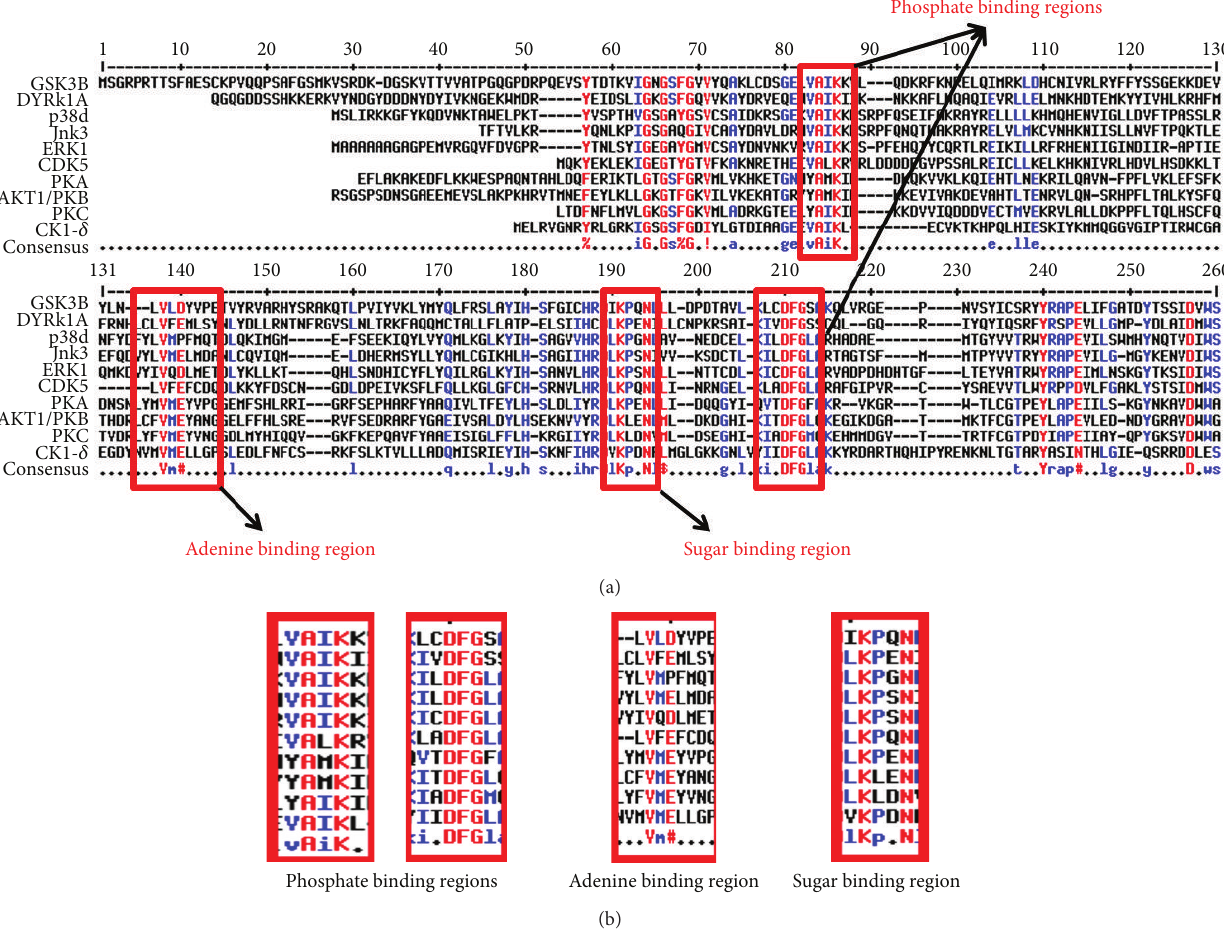
Figure 3: (a) Alignment of tau kinases showing the conserved residues in the ATP binding region. (b) Highlight of sequence conservation across ATP binding